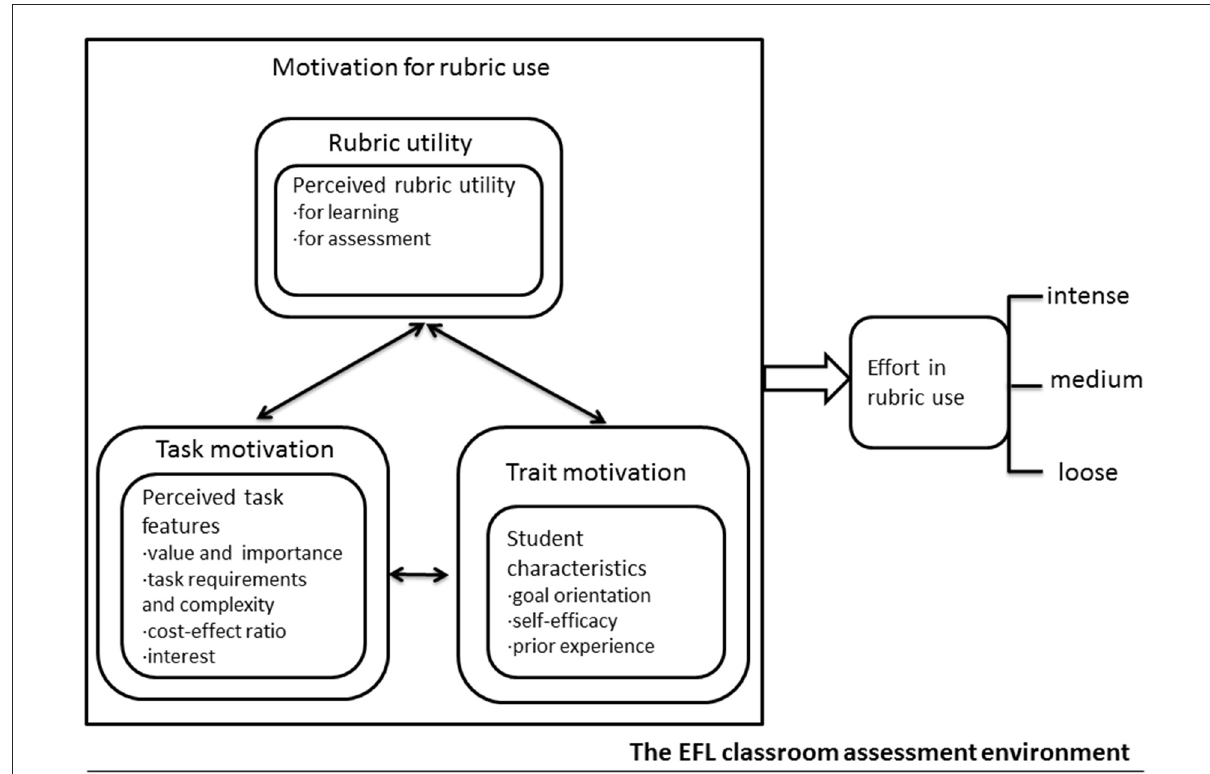
FIGURE1 Students’ motivation for rubric use in the EFL classroom assessment environment: A data-driven